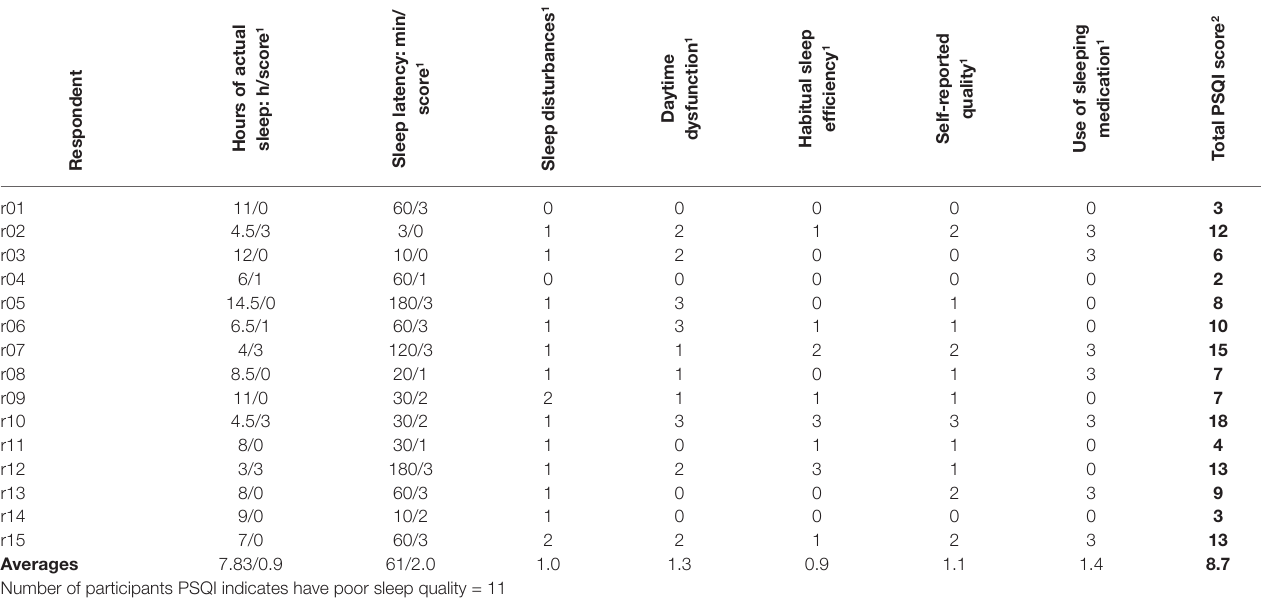
TABLE 1 | Participant itemized PSQI scores, hours of sleep, and minutes sleep latency.